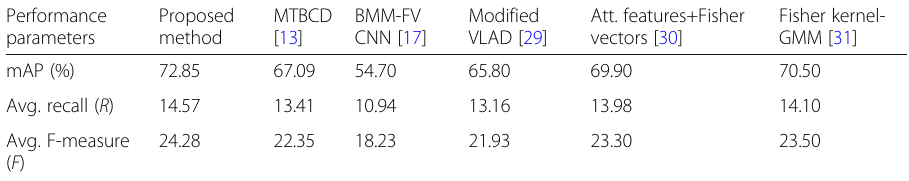
Table 6 Comparative analysis of competitive methods with a proposed method on the Holidays